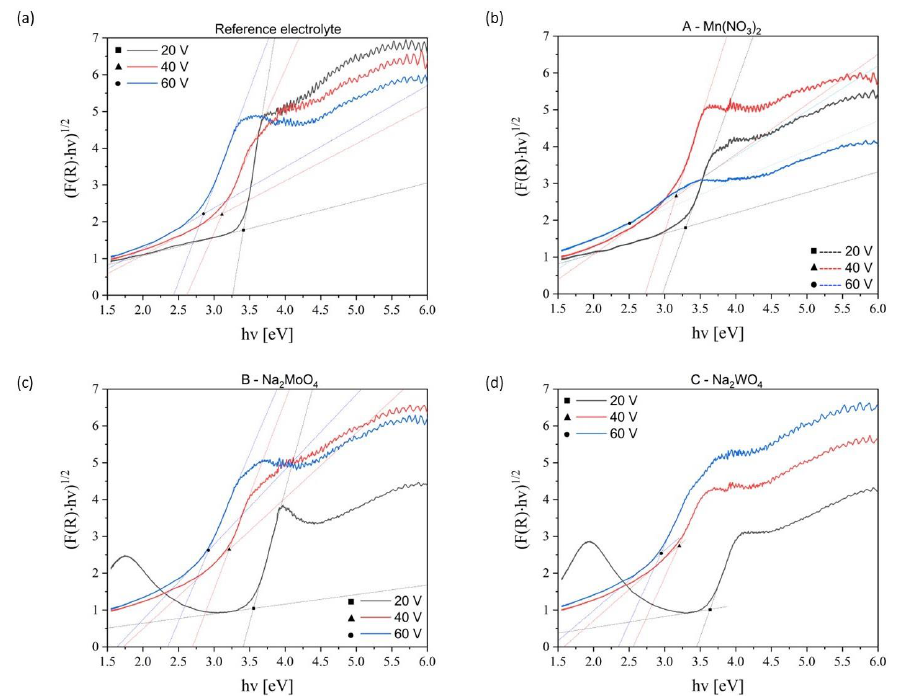
Figure 4. The Tauc plots used to estimate the bandgap of prepared anodic titanium oxide prepared in reference ( a ), A—Mn(NO 3 ) 2 ( b ), B—Na 2 MoO 4 ( c ), and C—Na 2 WO 4 ( d ) electrolytes at 20 V, 40 V, and 60 V. Table 5. Bandgap (eV) of anodic oxide prepared in reference and modified electrolytes with corresponding wavelength (nm) and region of sunlight.